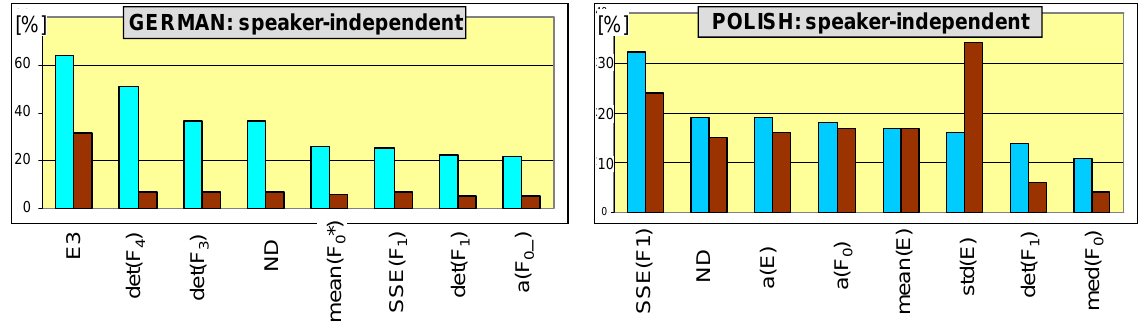
Figure 6. Best-performing features in emotion sensing for speaker-independent recognition among triplets (brown bars) and quadruples (turquoise bars) for German and Polish